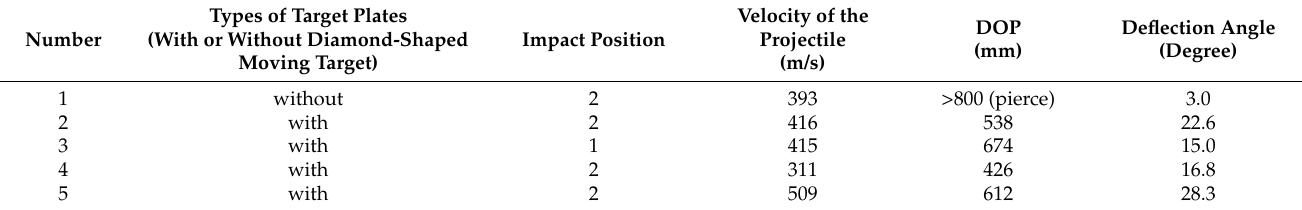
Figure 10. Schematic diagram of experimental measurement. Table 1. Experimental conditions and results.